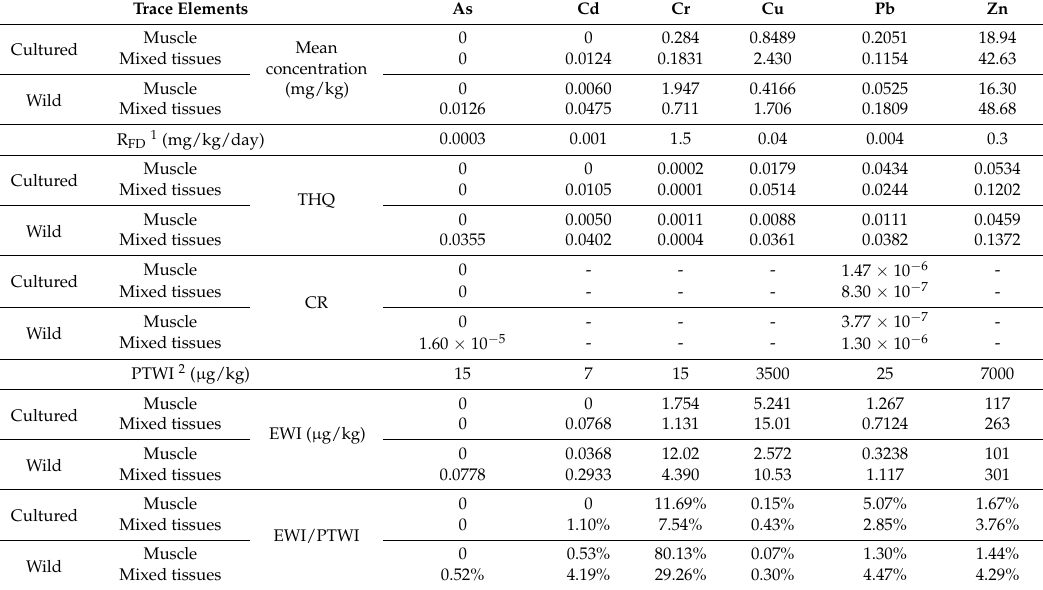
Table 4. Calculation results of target hazard quotients (THQ), carcinogenic risk (CR) and estimated weekly intake (EWI) from cultured and wild fish